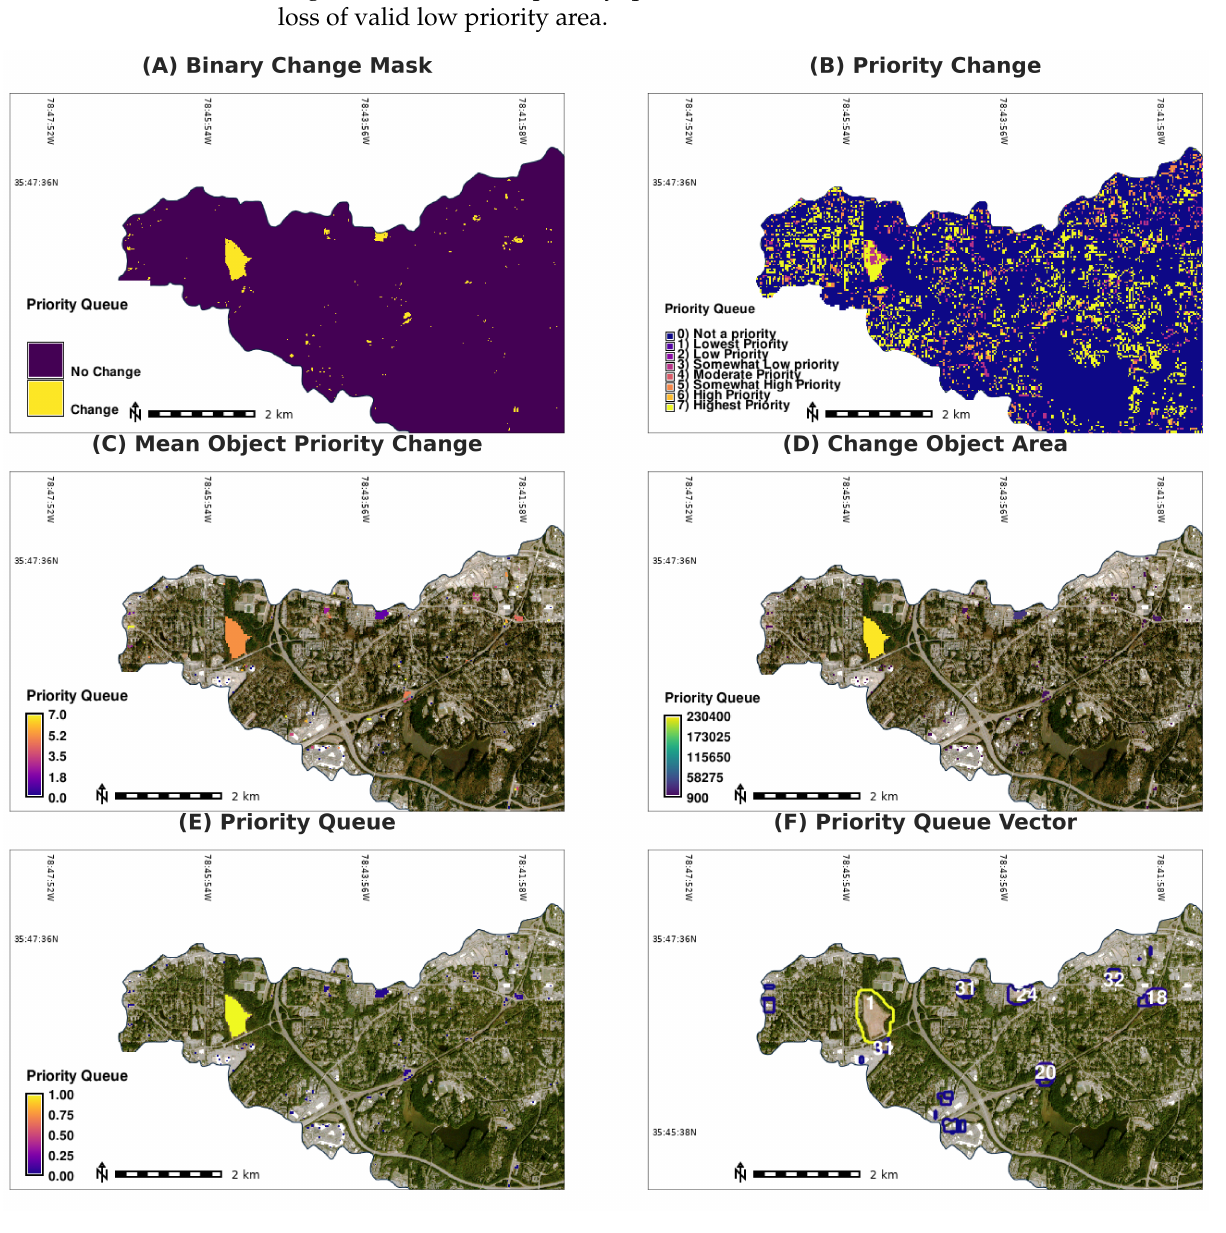
Figure 6. By zooming in on the northwest corner of the Walnut Creek watershed the steps involved in calculating the priority queue are illustrated as follows: ( A ) binary change mask was used to filter noise seen in the ( B ) priority change map. The ( C ) mean priority change of each of these objects was then calculated and weighted by the ( D ) change objects area producing the ( E ) priority queue. The priority queue was then converted to ( F ) priority queue vector for use with UAS flight planning